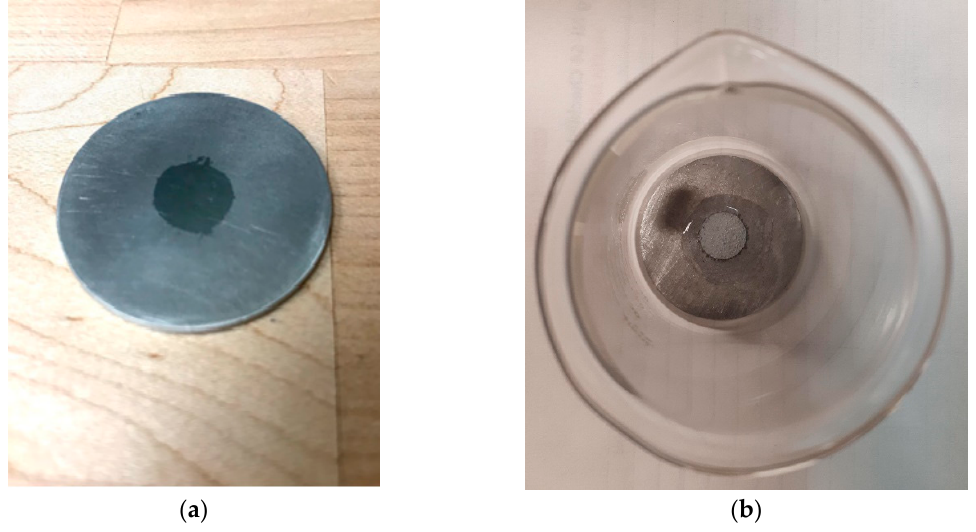
Figure 3. ( a ) Target plate after irradiation. The streaks of zinc on the aluminum plate are caused by the polishing. ( b ) Target plate being dissolved inside a beaker. polishing. ( b ) Target plate being dissolved inside a